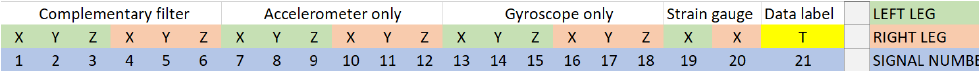
Figure 4. Sensor data structure consisting of 21 signals.